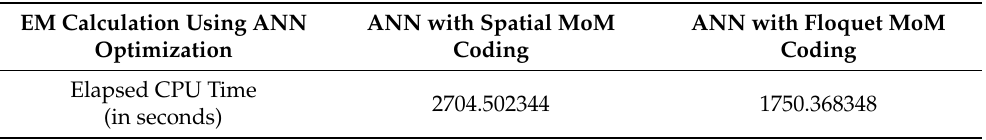
Table 3. Total CPU time (in seconds) used by electromagnetic calculation optimized through an ANN